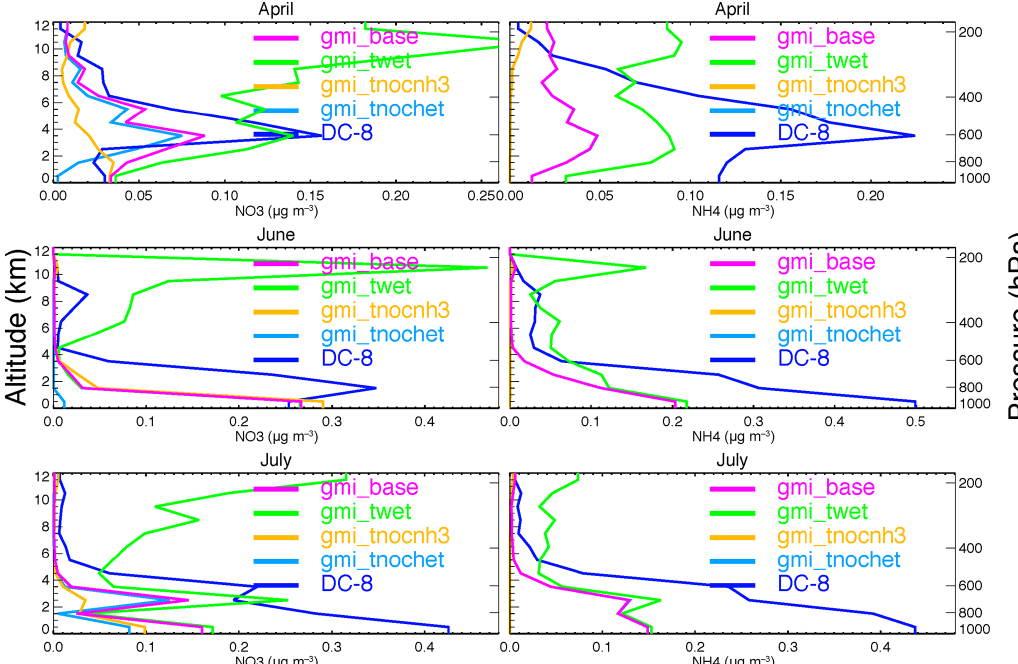
Figure 9. Comparison between GMI simulations and ARCTAS measurements of NH + sensitivity experiments explained in Table 6. Note that the light blue line for [NH +